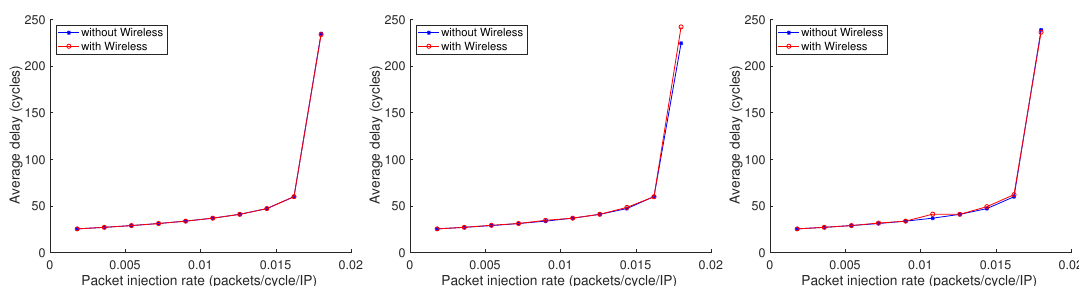
Figure 13. Average delay for profiles T 16 , T 32 , and T 64 for 1024 Delta MIN topology and random traffic (TR-1024 Delta MIN).